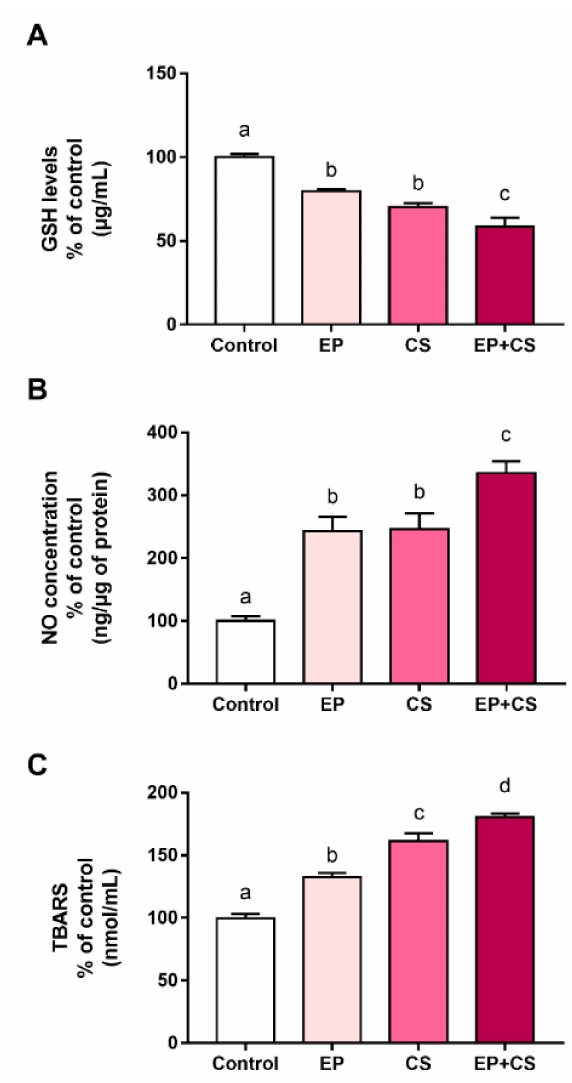
Figure 2. E ff ects of experimentally induced chronic immobilization stress and ligature-induced periodontitis on oxidative biochemical paraments of male Wistar rats (90-days-old, n = 28) in the blood. Results are expressed as mean ± standard error of mean of control percentage of ( A ) glutathione (GSH) levels; ( B ) nitric oxide (NO) levels; and ( C ) lipid peroxidation (TBARS). One-way ANOVA and Tukey’s post-hoc test, p < 0.05. Similar overwritten letters do not reveal statistically significant di ff erences. EP: ligature-induced experimental periodontitis group; CS: chronic stress by physical restraint model; CS + EP: association of chronic stress and ligature-induced